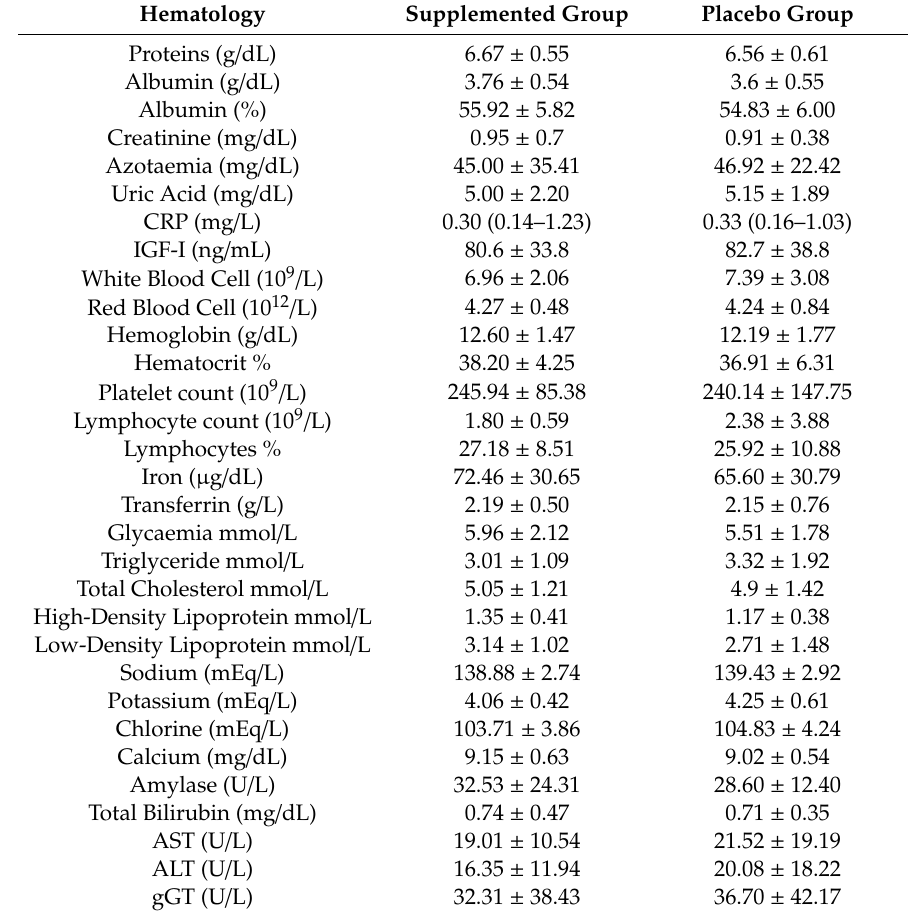
Table 2. Baseline biochemical parameters of the participants 1